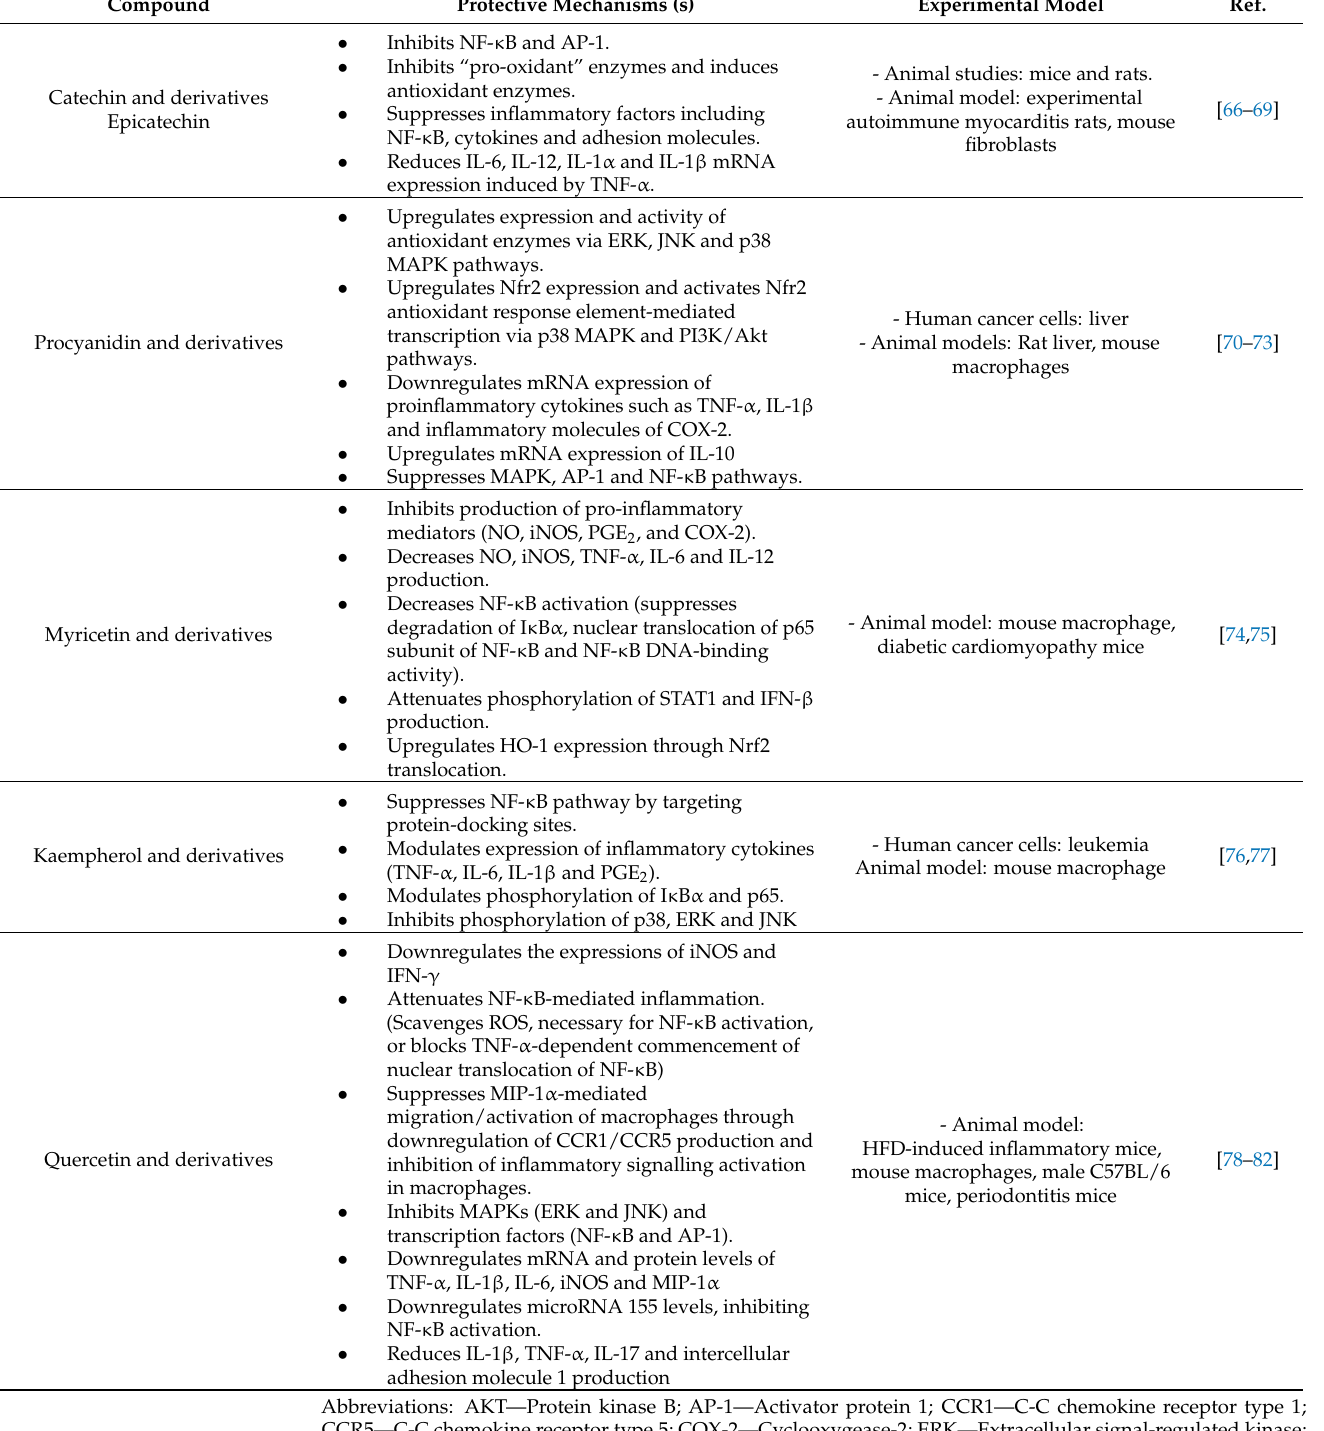
Table 4. Protective mechanisms ascribed to phenolic compounds identified in C. album leaves. Compound Protective Mechanisms (s) Experimental Model